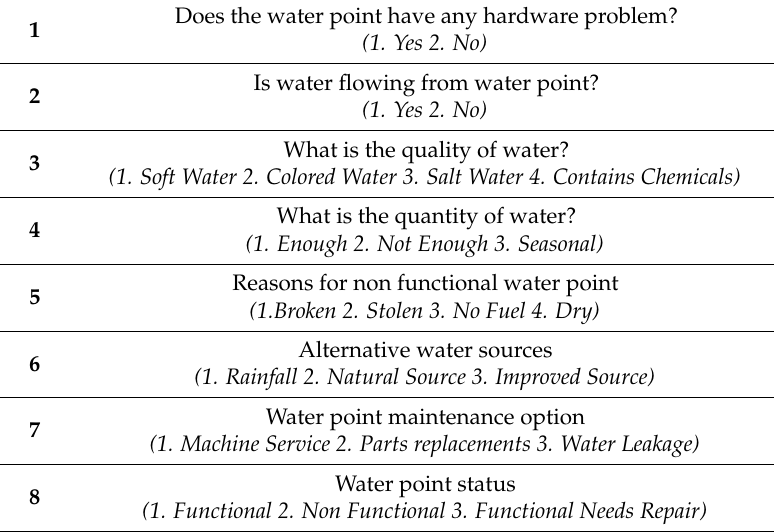
Table 2. The software algorithm inscribed in the SEMA